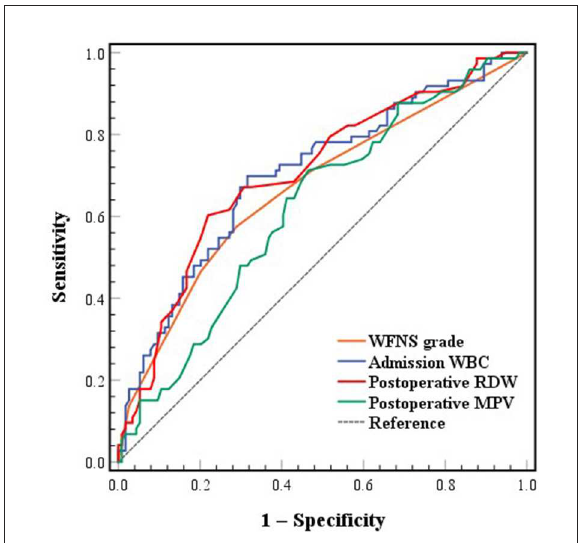
FIGURE2 ROC curves of WFNS grade, admission WBC, postoperative RDW and MPV associated with poor functional outcome at 3 months. ROC, receiver operating characteristic; WFNS, World Federation of Neurosurgical Societies; WBC, white blood cell; RDW, red blood cell distribution width; MPV, mean platelet volume.